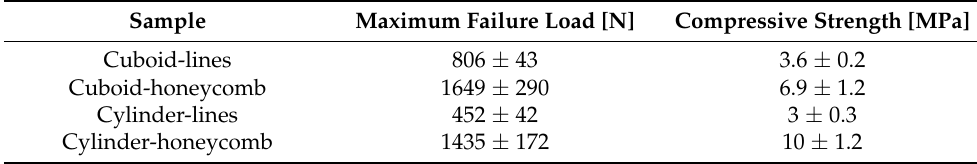
Table 3. Maximum failure load and compressive strength for the different scaffolds (n =